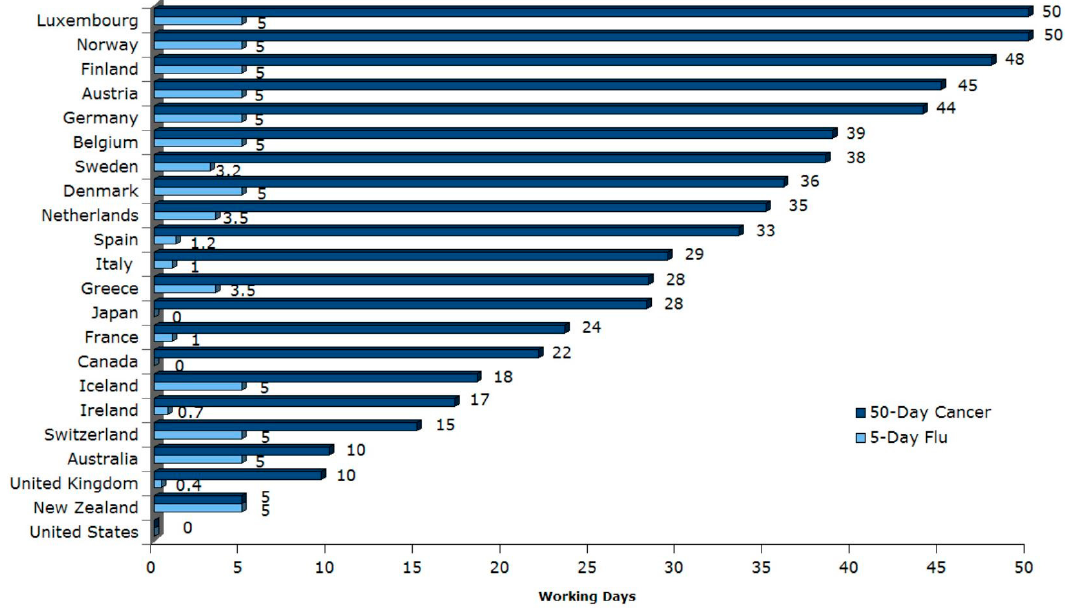
Figure 1. Paid Sick Days and Leave in 22 Countries, Median Worker. Source: [5].